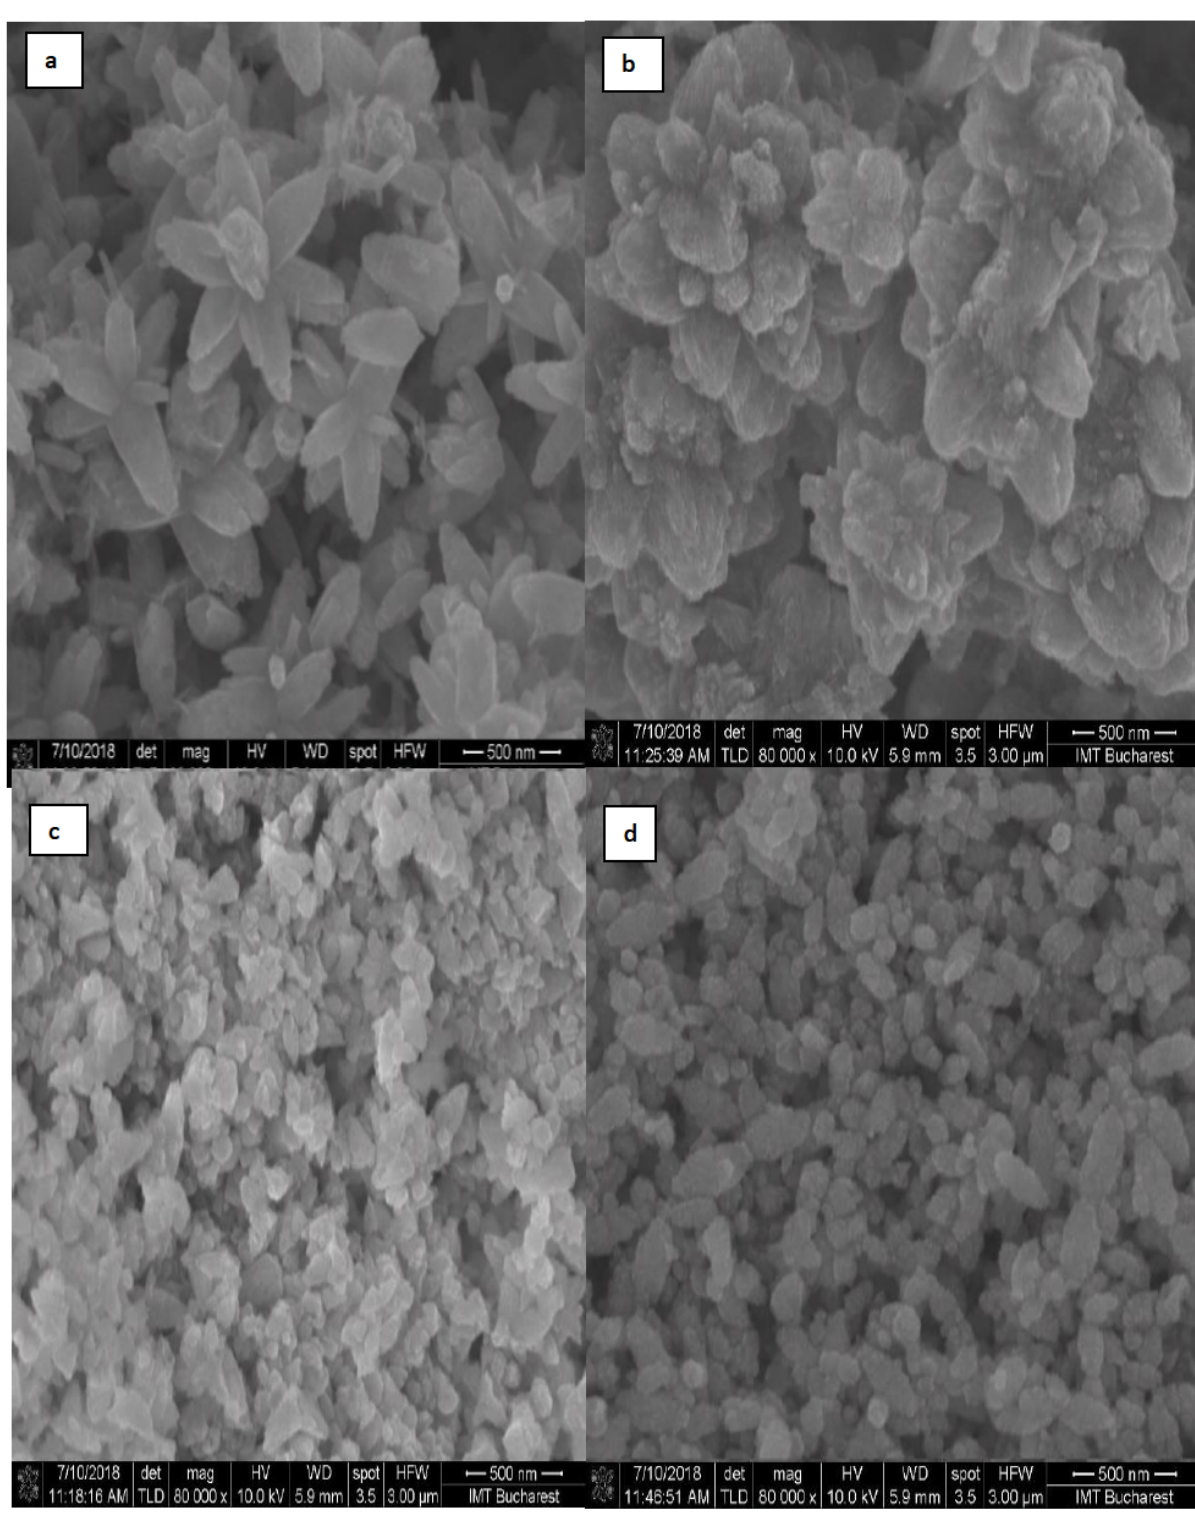
Figure 5: SEM images of the ZnO-1.4% Graphene nanocomposites sonochemically prepared at pH=14 (b) pH=11.5, (c) pH=10, (d) pH=8.5, after drying process at 150 ∘ C in